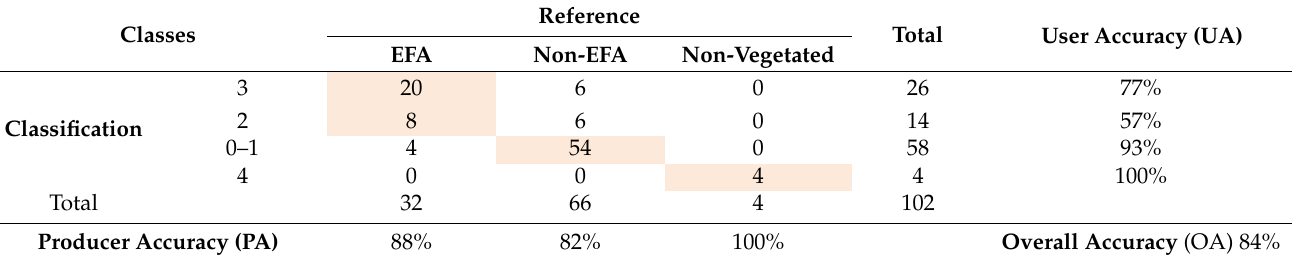
Table 4. Confusion matrix of EFA map after merging Classes 0 and 1 (non-EFA plots): Matrix elements are reported in the number of fields. Orange cells represent the number of fields used to compute